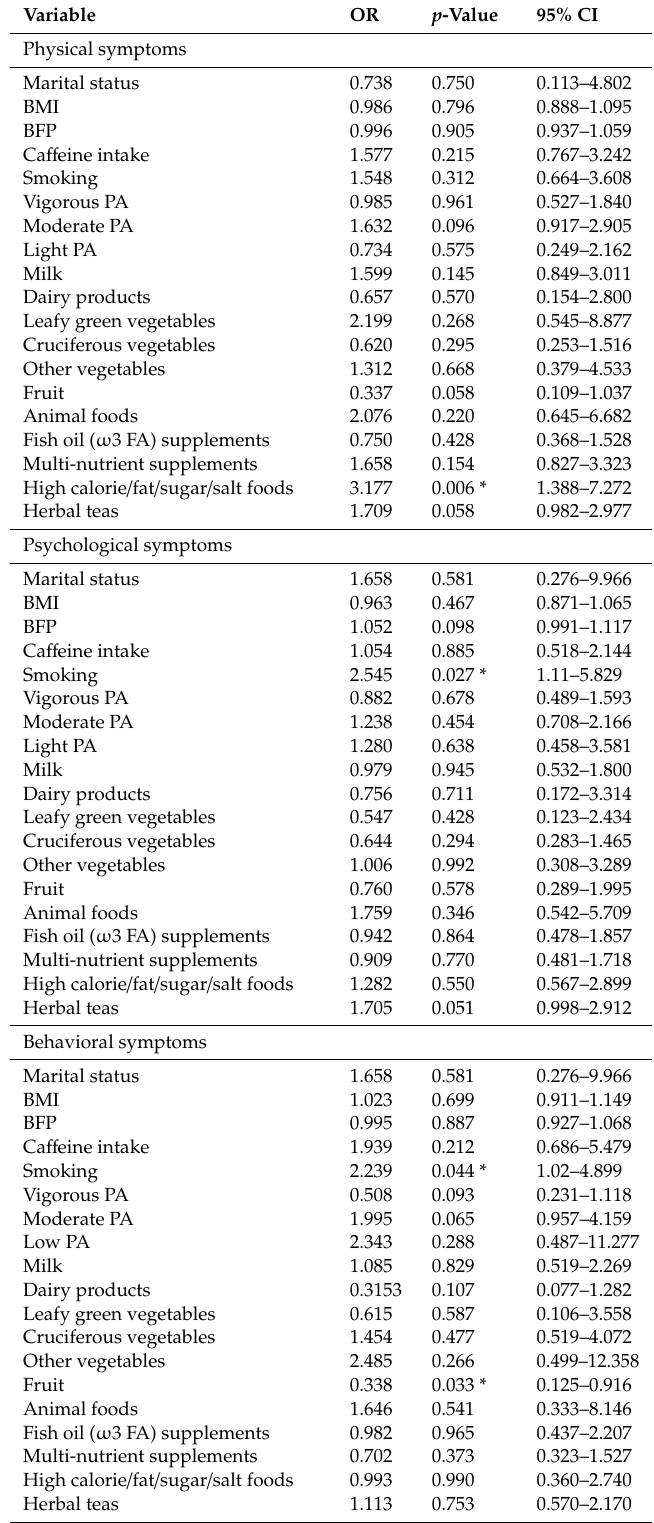
Table 4. Multiple regression analysis for dietary and lifestyle behaviors and associations with premenstrual